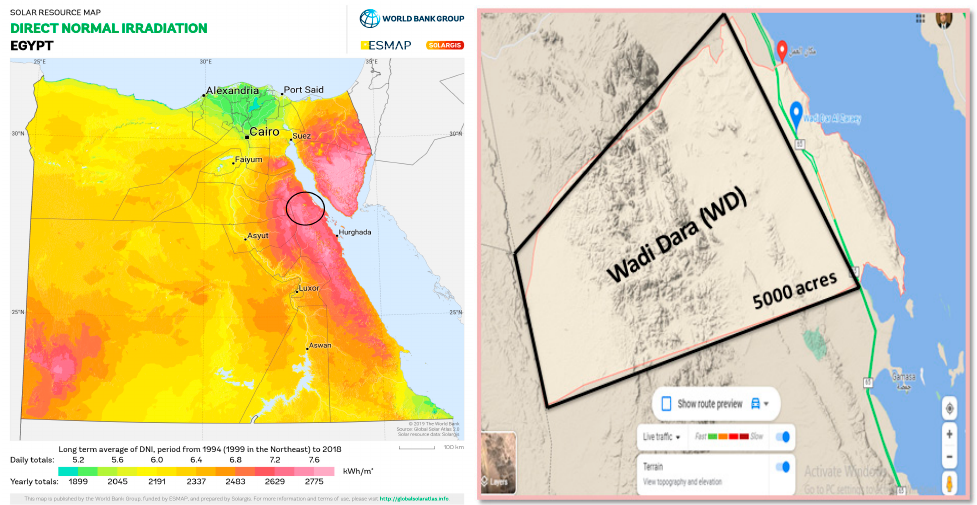
Figure 2. Wadi-Dara (WD) location at Red Sea coast and sun irradiation.